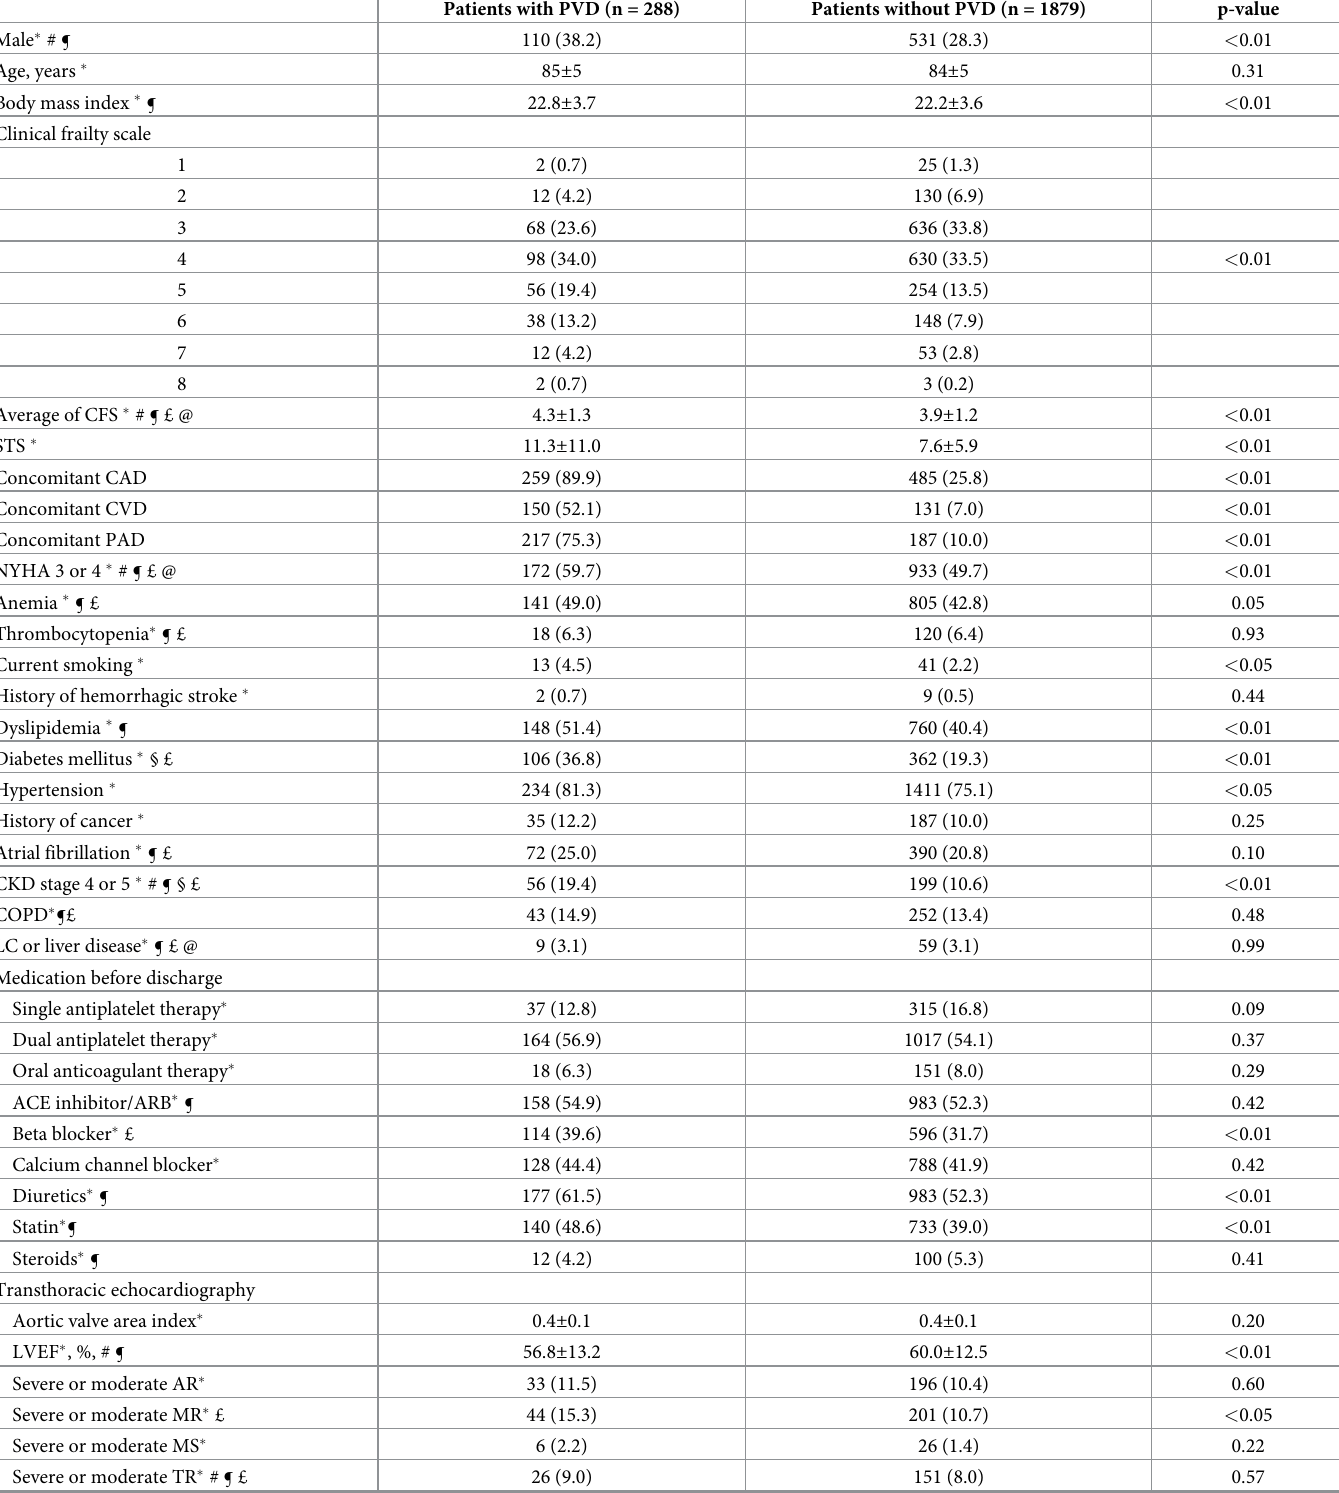
Table 1. Patient background, medical therapy at discharge, baseline transthoracic echocardiography findings, and procedural